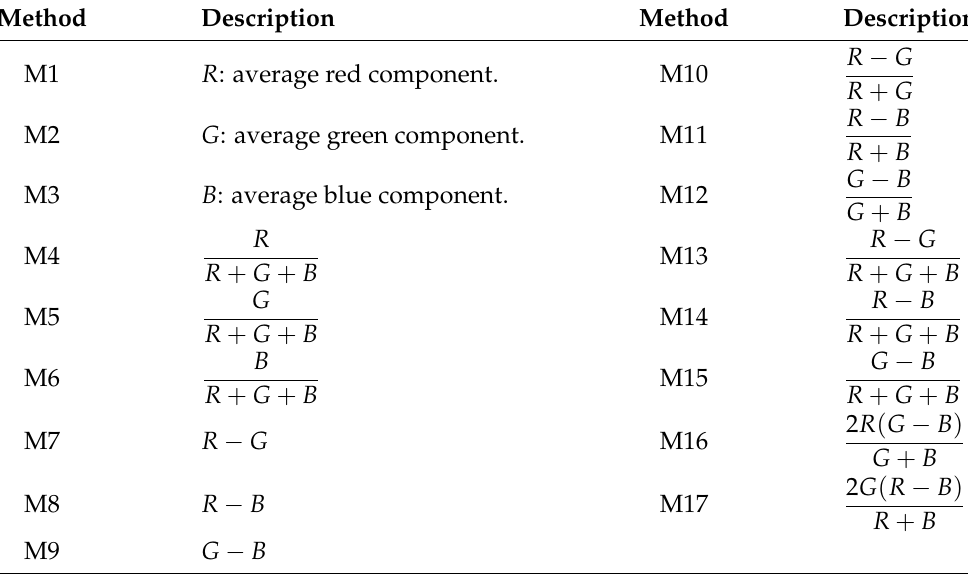
Table 2. List of leaf color-analysis-based nitrogen estimation metrics used in performance